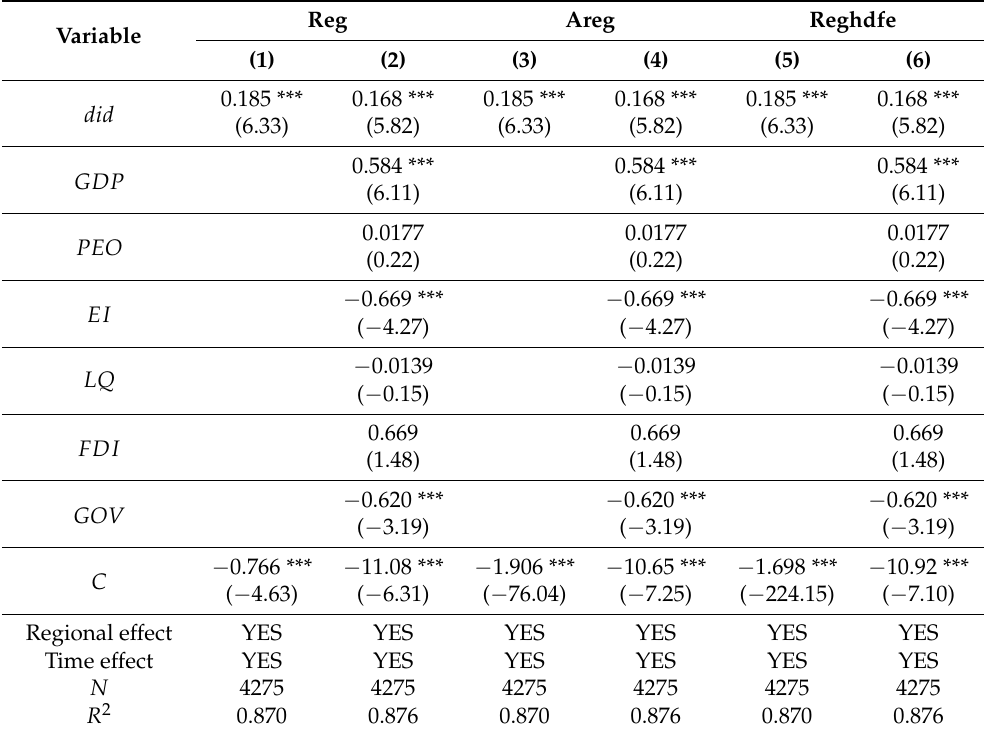
Table 4. Estimation results of models using different multi-period DID